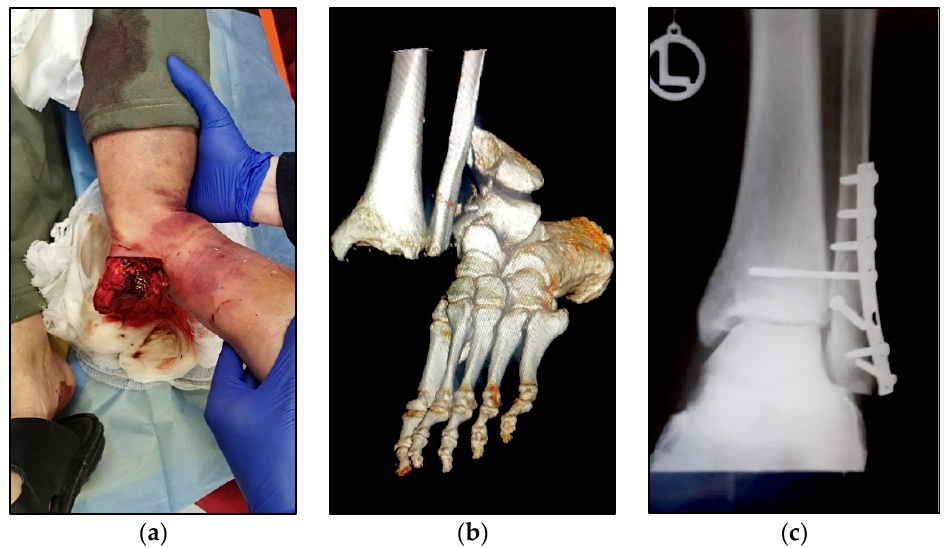
Figure 2. Examples of initial presentation and radiographic findings in severe ankle fractures that require talofibular trans-syndesmotic screws: ( a ) pre-operative aspect; ( b ) pre-operative computed tomography 3D reconstruction; ( c ) post-operative x-ray in frontal view.